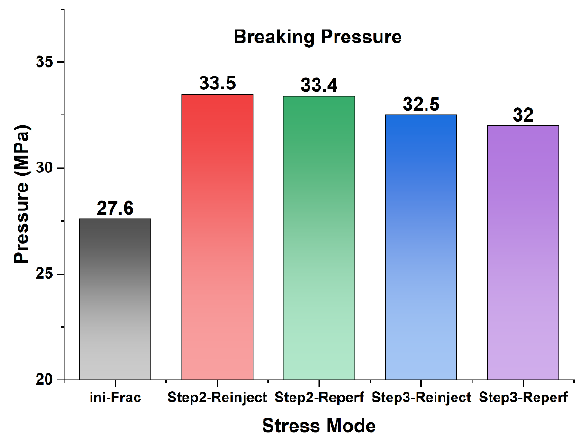
Figure 12. Breaking pressure of different fracturing methods.